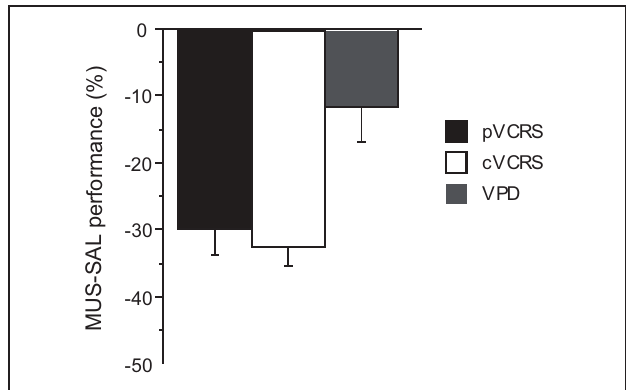
FIGURE 6 | Comparison of the performance drops with MUS- compared to SAL-injected conditions across the tasks. The ordinate represents the difference in average performance (% correct) between the drug conditions on each task. Note the bigger drops in performance with MUS in the VCRS tasks as compared to the VPD task. All graphs show mean ±